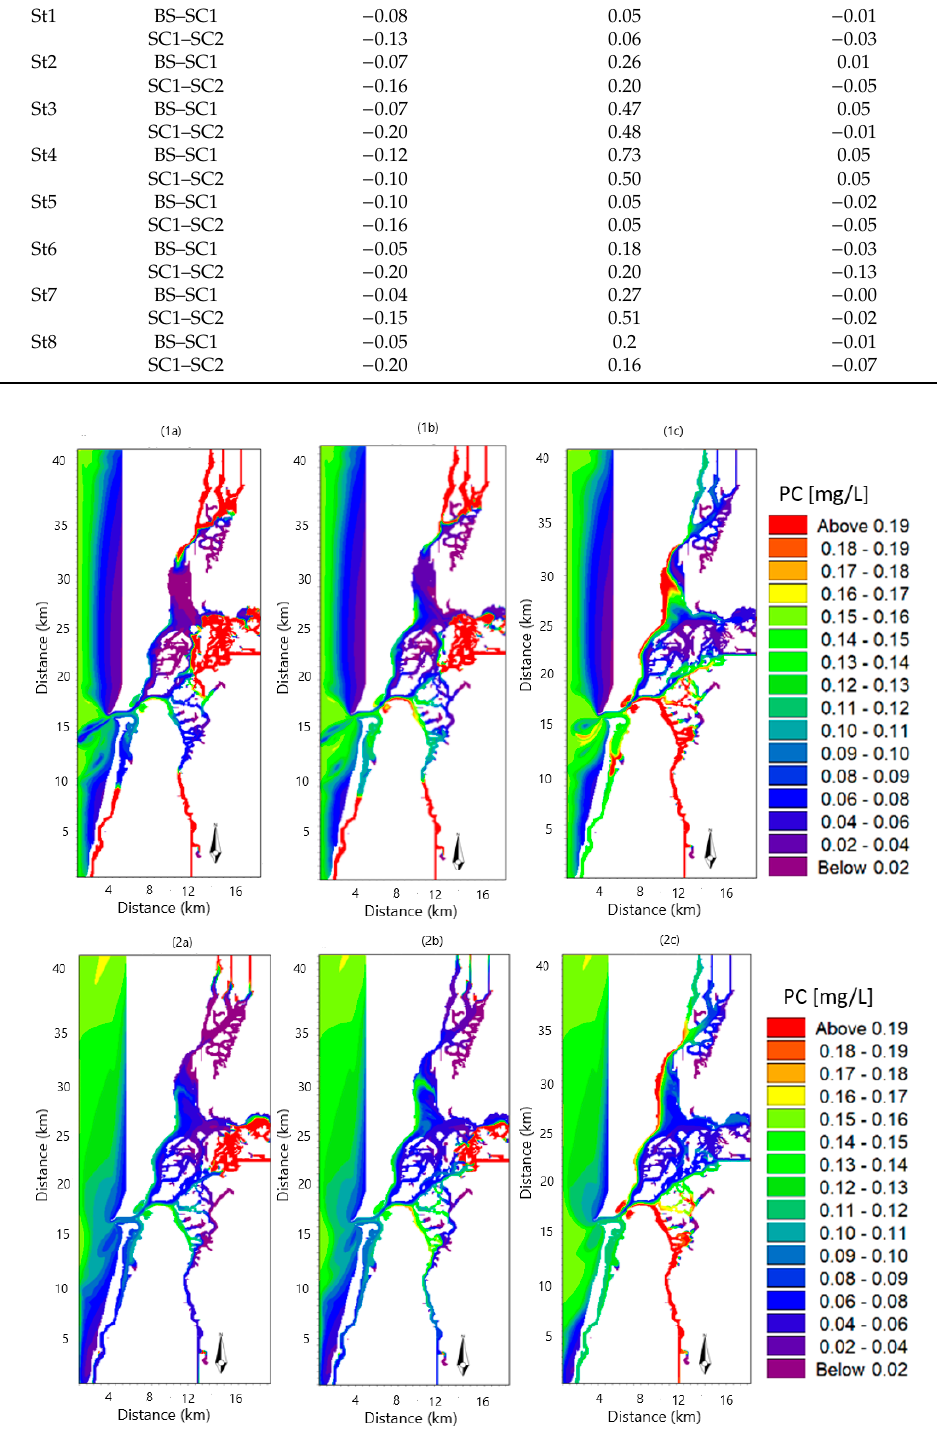
Figure 17. Snapshots of surface concentration of carbon phytoplankton, PC, for BS ( a ), SC1 ( b ) and SC2 ( c ), for two instants: 1—high tide, flooding at the lagoon mouth and ebbing at the mouth of the rivers (17/9/2000); 2—high tide, ebbing at the lagoon mouth and flooding at the mouth of the rivers (27/9/2000).